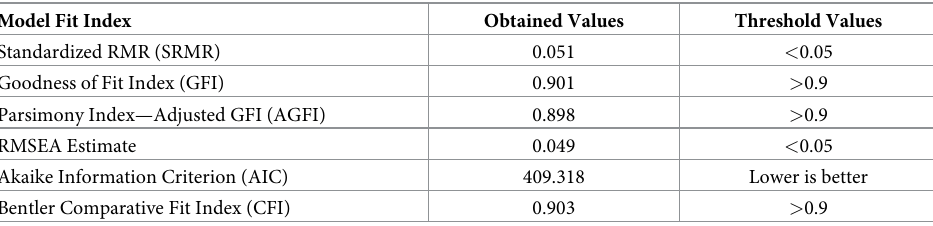
Table 5. Summary of model fit